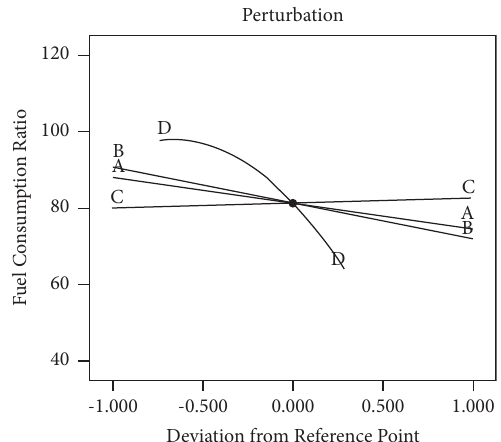
Figure 10: Trace plot for fuel consumption ratio.